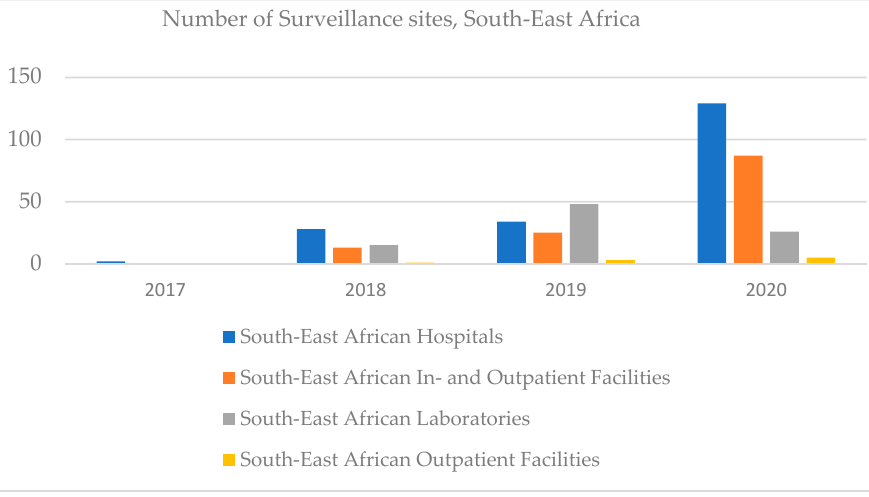
Figure 9. Number of surveillance sites, Western Pacific, 2017–2020. In Africa, the hospitals variable is strongly and directly correlated to clinical labora- tories and inversely and weakly correlated to outpatient facilities. Clinical laboratories are medium and direct correlated to clinical laboratories (Table 2). Table 2. Correlation matrix, Africa. Hospitals